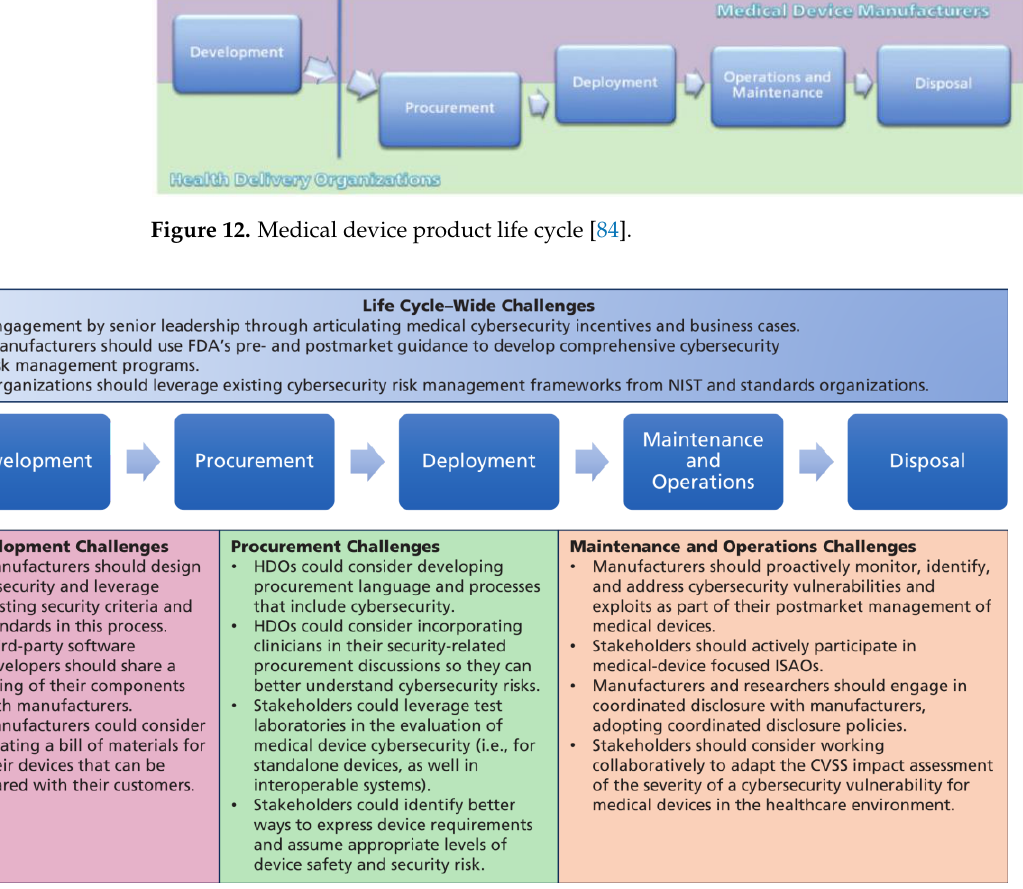
Figure 13. Summary of medical device cybersecurity life cycle challenges. Abbreviations used: CVSS, Common Vulnerability Scoring System; FDA, Food and Drug Administration; HDO, Healthcare Delivery Organization; ISAO, Information Sharing and Analysis Organizations; and NIST, National Institute of Standards and Technology [84].